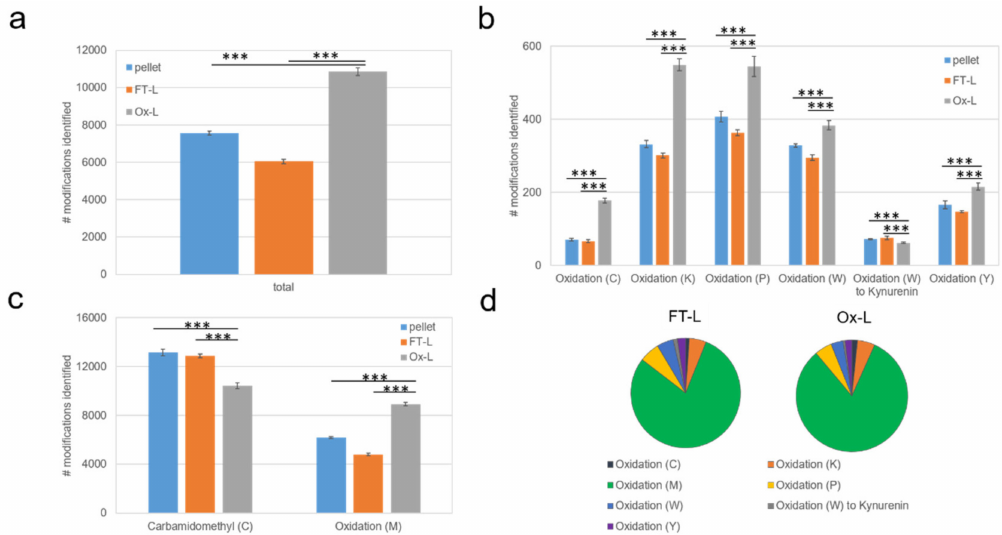
Figure 2. HOCl increases post-translational modifications on Met, Lys, Pro, Cys Trp and Tyr in cancer cells, in vitro. Proteomics results including the oxidations as variable modifications. ( a ) Bar plot reporting the average number of oxidized Met, Lys, Pro, Cys, Trp and Tyr residues ± standard deviation identified in the indicated conditions ( n = 4 technical replicates). ( b ) Same as (a) with each oxidized modification reported separately. ( c ) Bar plot reporting the average number of Carbamidomethyl modifications on Cys residues and of oxidized Met residues ± standard deviation identified in the indicated conditions ( n = 4 technical replicates). ( d ) Distribution of total number of oxidative modifications identified on average in indicated samples. Data were analyzed with unpaired student t-test: *** p <